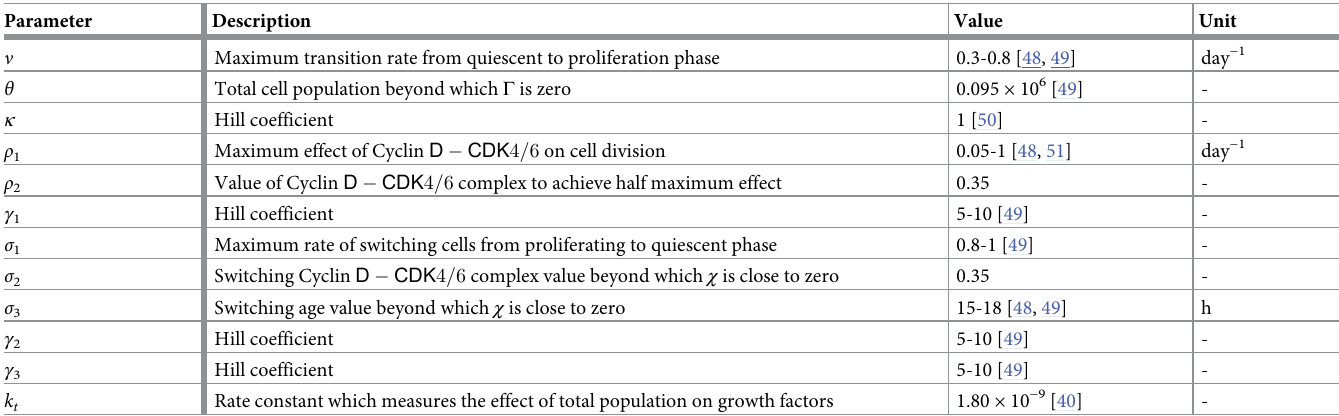
Table 3. Parameters used in the